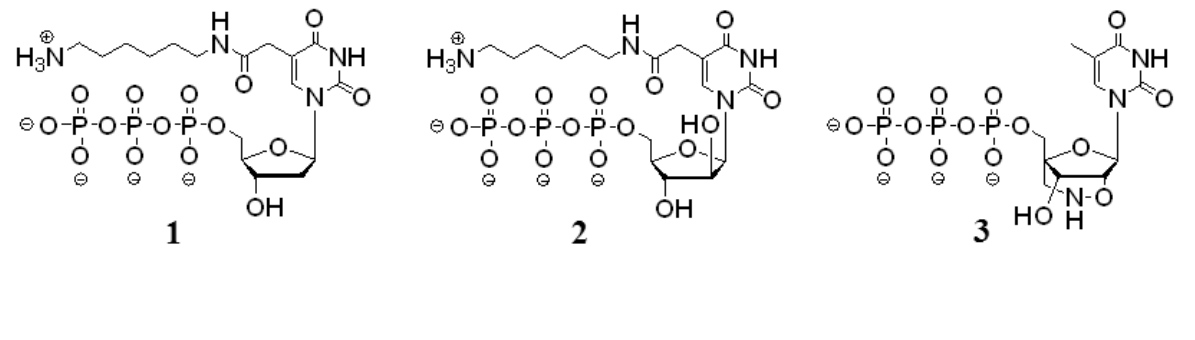
Figure 1. Chemical structures of the thymidine 5 ′ -triphosphate analogues used in this